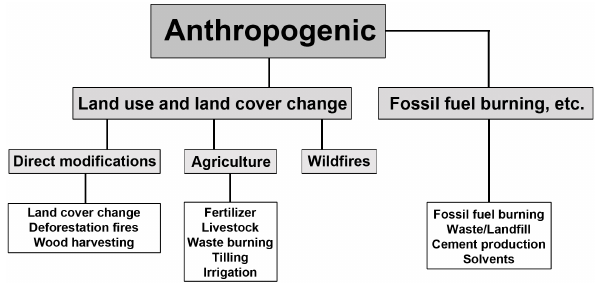
Figure 1. Breakdown of anthropogenic activities into categories as- sociated with land use and land cover change, and fossil fuel burn- ing. Note that “wildfires” refers only to the change in wildfire activ- ity (non-deforestation and non-agricultural fires) that results from anthropogenic land use and land cover